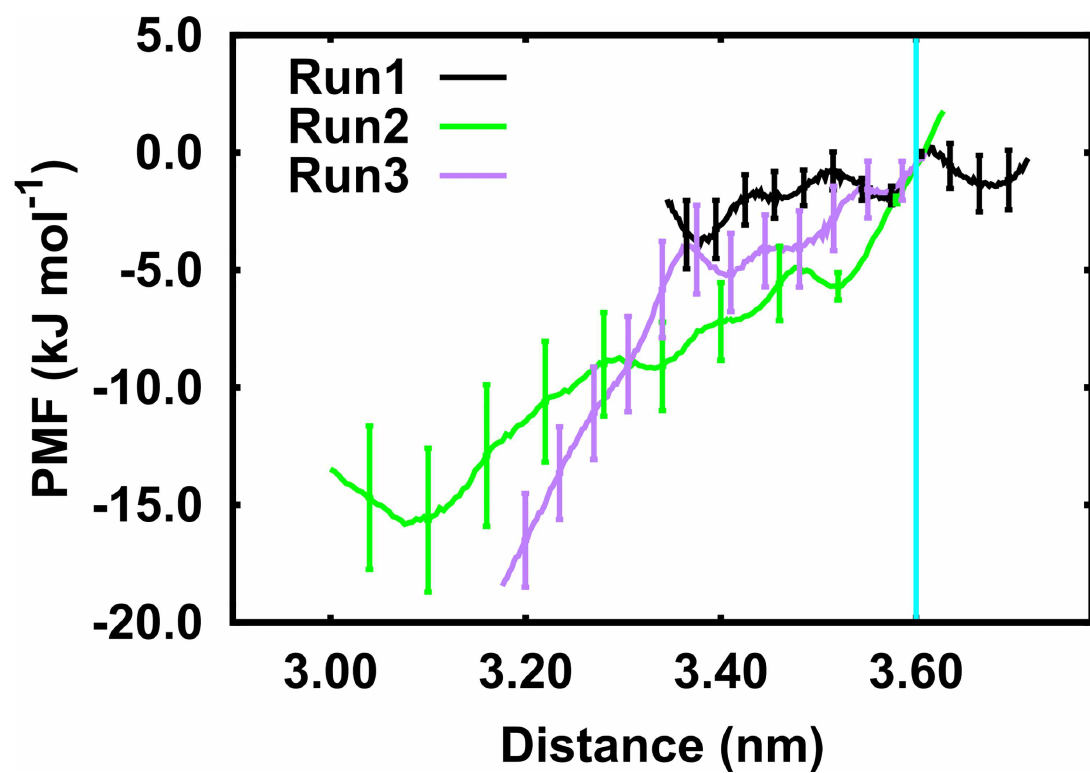
Fig 6. Potential of Mean Force (PMF) of TM1A movement. The center of mass distance between the C α atoms of TM1A (residues 11 to 20) and the C α atoms of IL1 (residues 78–81), TM8 (residues 363–366) and TM12 (residues 503–504)was used as reaction coordinate.The PMFs were constructed using umbrella samplingcombinedwith the weightedhistogram analysis method, error bars were estimated by applyingthe bootstrap method. For simplicity, only every ~15 th error bar from the bootstrap results is shown. The distance measured in the inward-opencrystal structure is shown as vertical cyan line.